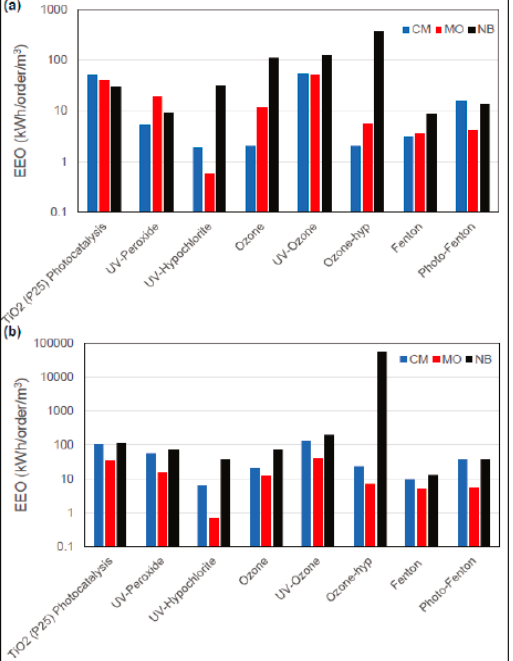
Figure 5. Observed EEO values for di ff erent AOPs in monocomponent ( a ) and multicomponent ( b ) solutions. Legend: CM = carbamazepine, MO = methyl orange, NB = nitrobenzene (from [36]). Advanced Oxidation Processes